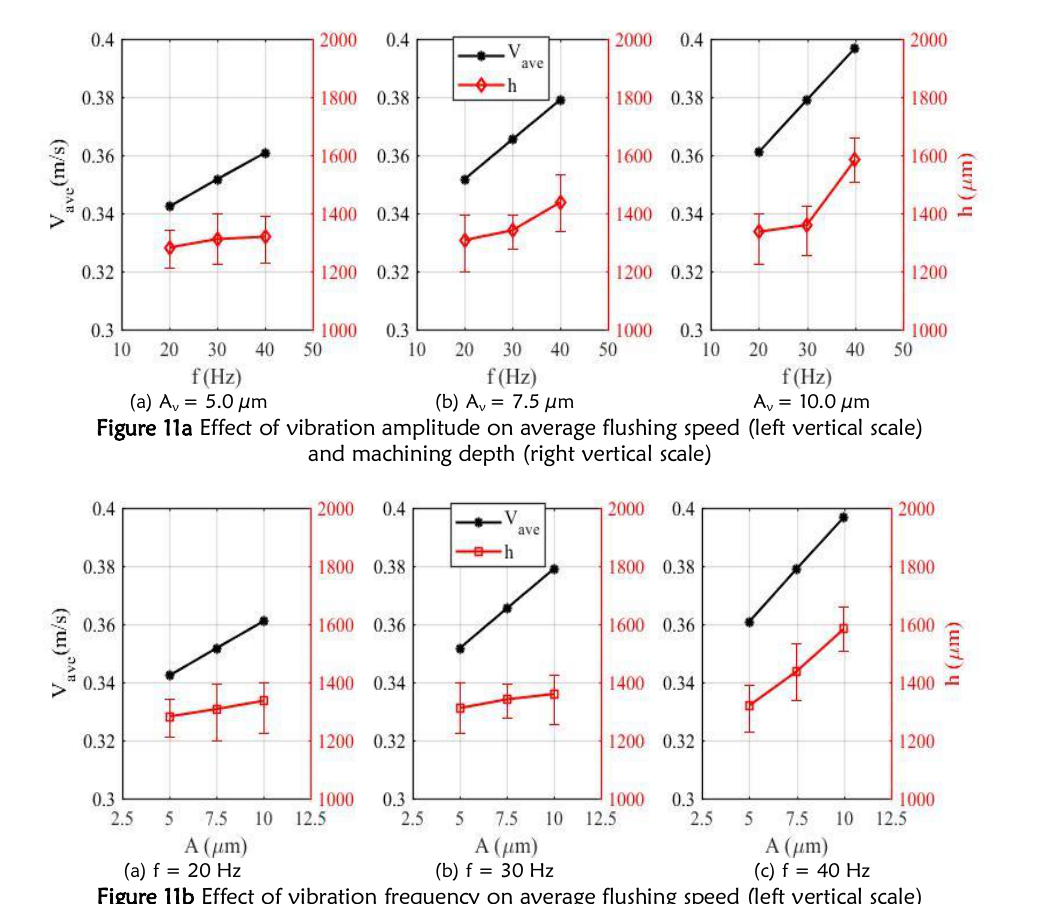
Figure 11b Effect of vibration frequency on average flushing speed (left vertical scale) and machining depth (right vertical scale)